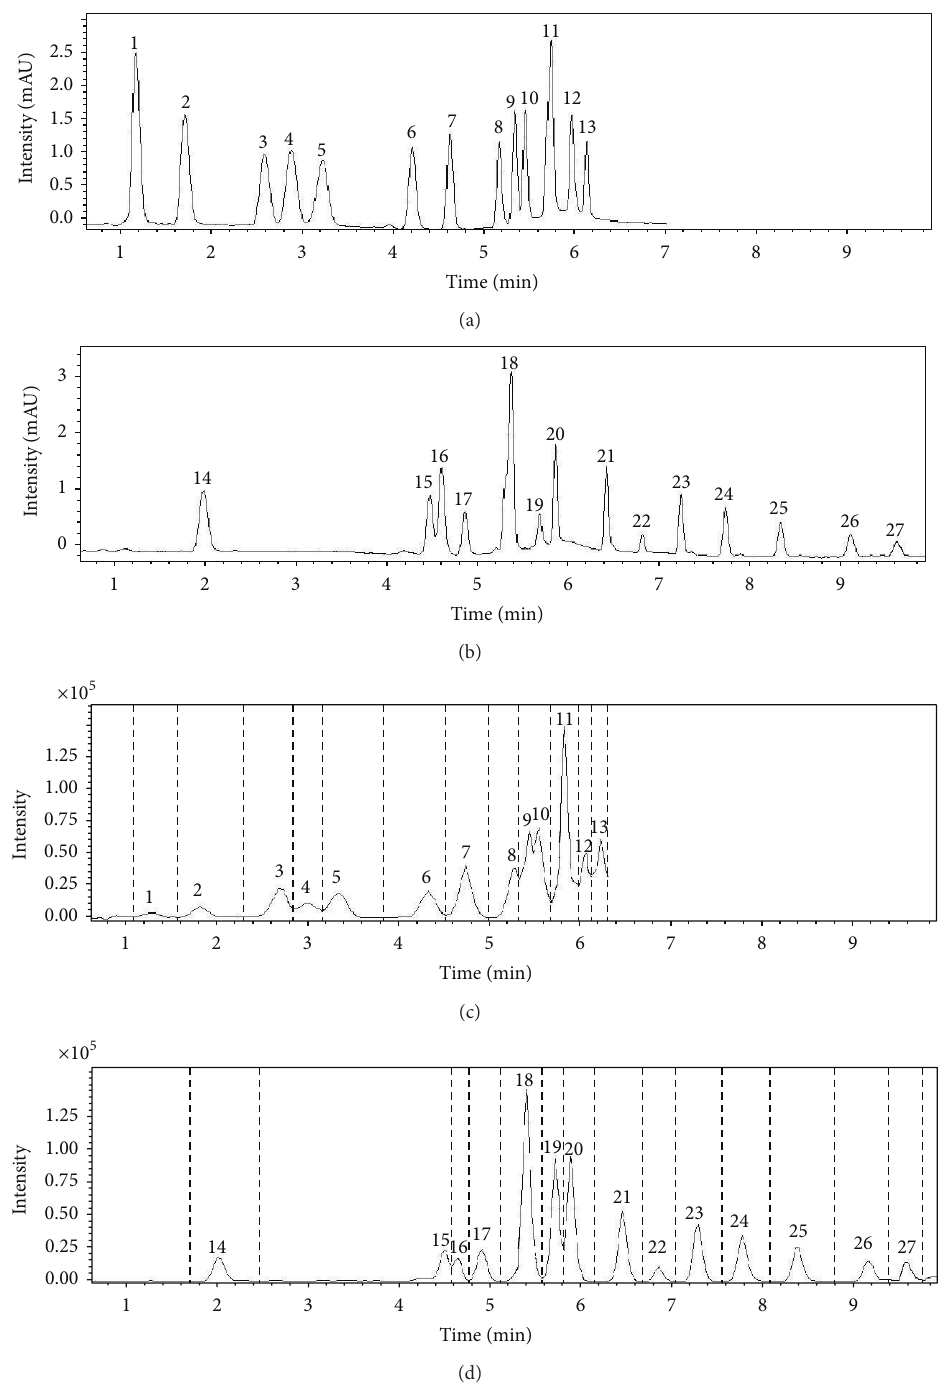
Figure 4: Chromatograms of a mixture of ((a) and (c)) CC-DNPH derivatives from T011/IP-6A Supelco and ((b) and (d)) hydrazones of selected CC synthesized (200 𝜇 gL −1 ) by RRLC-UV-DAD method ((a) and (b)) and by RRLC-APCI-MS/MS method ((c) and